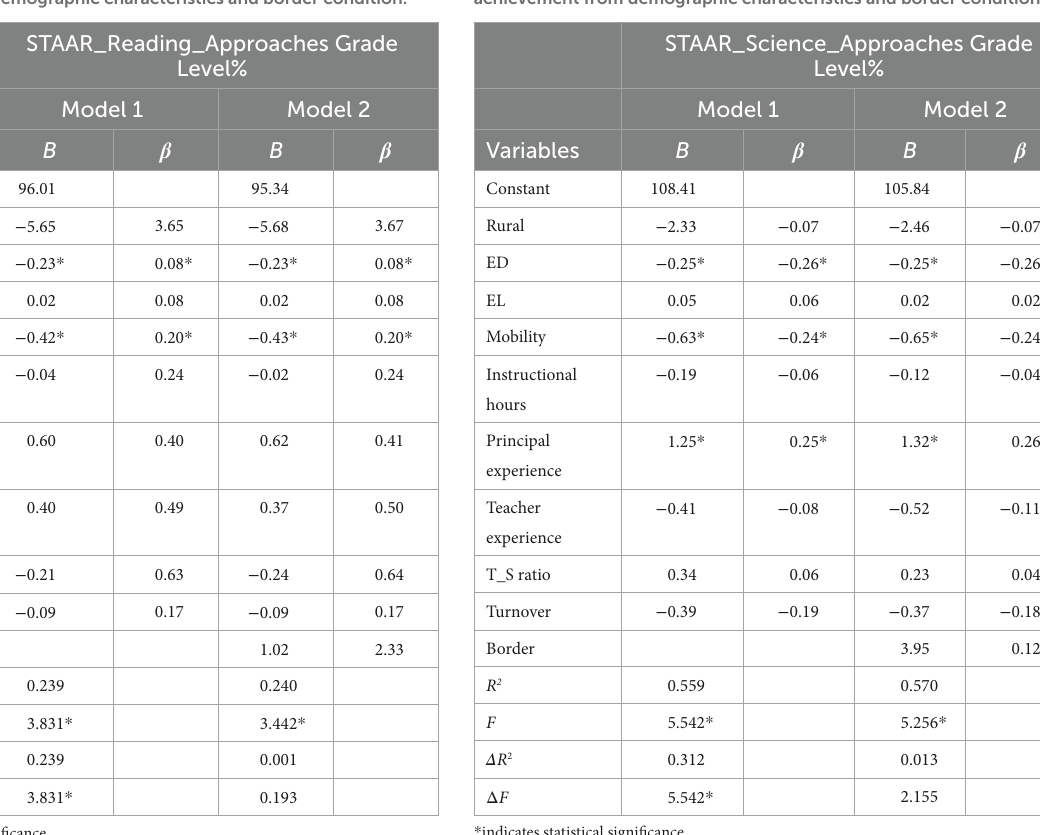
TABLE 6 Hierarchical multiple regression predicting student science achievement from demographic characteristics and border condition.